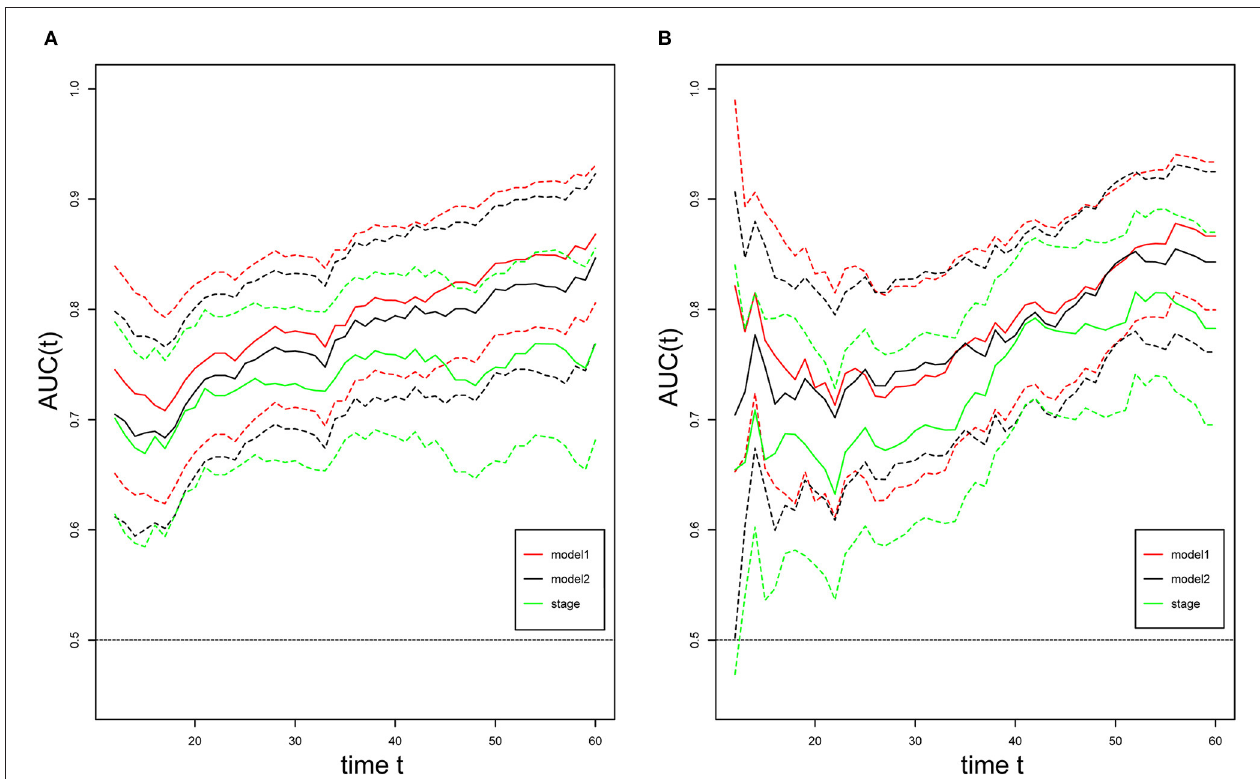
FIGURE 4 | t-ROC curves. Time-dependent receiver-operating characteristic (ROC) curves for the newly-built nomogram, non- 1 L3SMI nomogram, and pTNM for the prediction of replase-free survival (A) and overall survival (B) . The horizontal axis represents month after surgery, and the vertical axis represents the estimated area under the ROC curve for survival at the time of interest. Red, green, and black solid lines represent the estimated AUCs of the newly-built nomogram (model1), non- 1 L3SMI nomogram (model2), and pTNM, respectively, and broken lines represent the 95% confidence intervals of each AUC. AUC, area under the curve; pTNM, pathologic TNM.